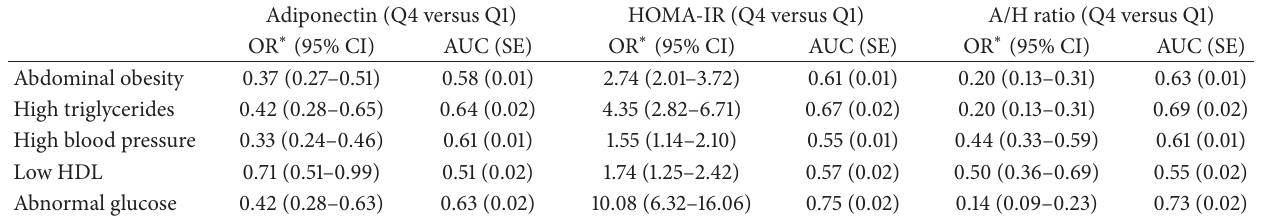
Table 4: Odds ratios (95% CI) and ROC analysis for the association between each component of MetS and markers.